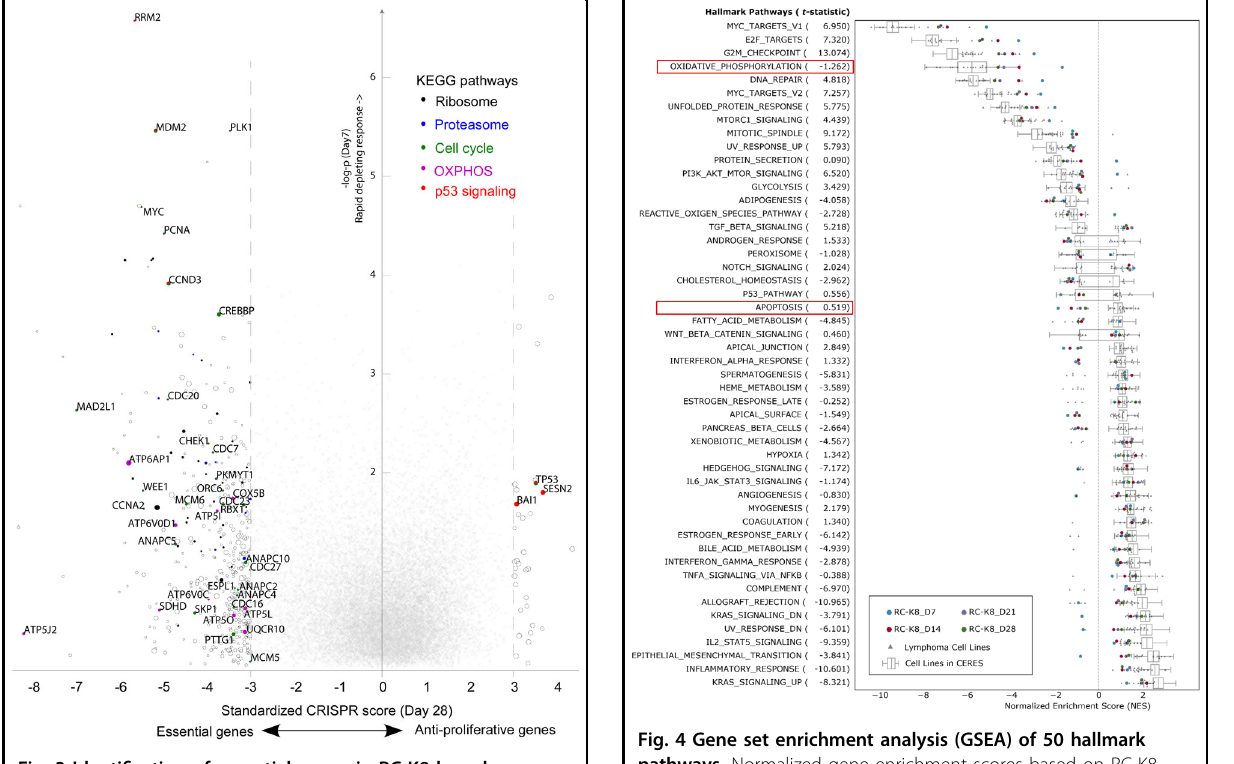
Fig. 3 Identi fi cation of essential genes in RC-K8 based on genome-scale CRISPR-Cas9 knockout screening. y -axis: signi fi cance of rapid responses to genetic perturbations observed at day 7; x -axis: standardized ( z -transformed) CRISPR score re fl ecting overall effects at day 28. Circles: genes with overall scores < − 3.0 (essential genes) or >3.0 (anti-proliferative genes); circle sizes are scaled by the average CERES score re fl ecting general essentiality in cancer cells, where smaller circles indicate cell-speci fi c dependencies, such as MDM2 , CREBBP and CCND3 . Genes involved in the fi ve indicated KEGG pathways are fi lled with colours.